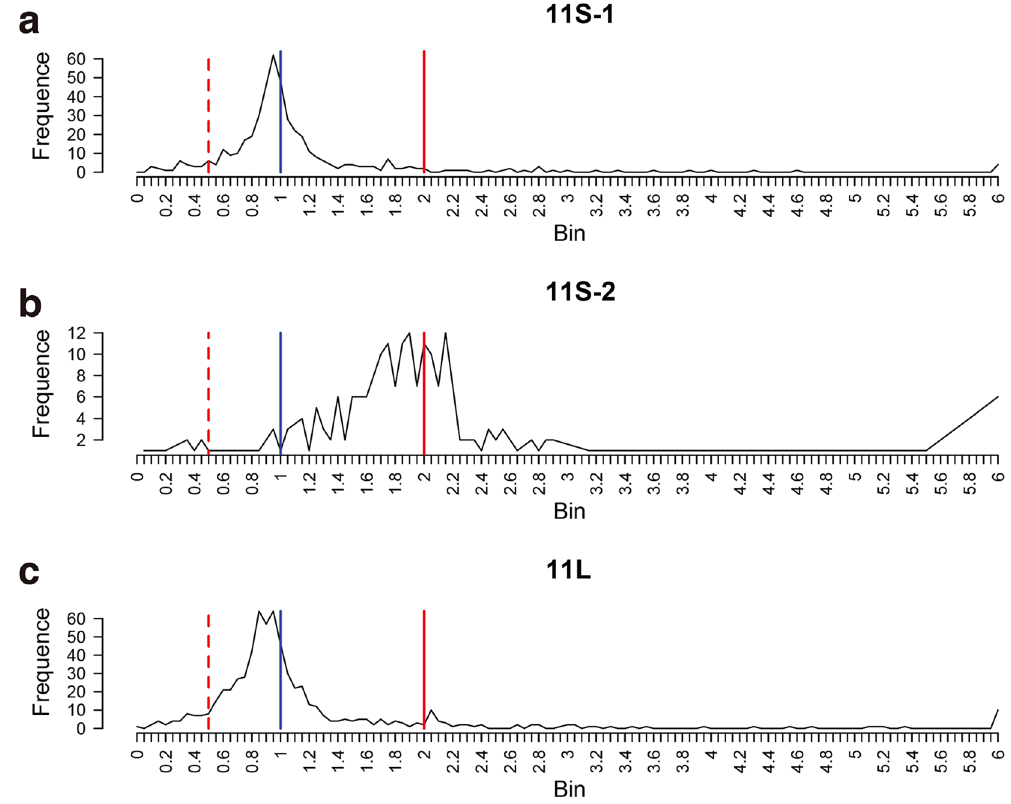
Figure 8. Global gene expression ratio distribution on Chr11 of YZG-5. The blue line represents the ratio 1.0 (no change), and the red solid line represents the ratios 2.0[the ratio of positive dosage effects (4/2)]. The red dashed line represents the ratios 0.5[the ratio of inverse dosage effects (2/4)]. The ratio distributions of gene expression on 11S-1 ( a ) and 11L ( c ) are roughly centered around 1.0, while the gene expression ratio distribution of 11S-2 ( b ) is centered around 2.0.X-axis represents ratio bin, Y-axis represents gene frequency in each